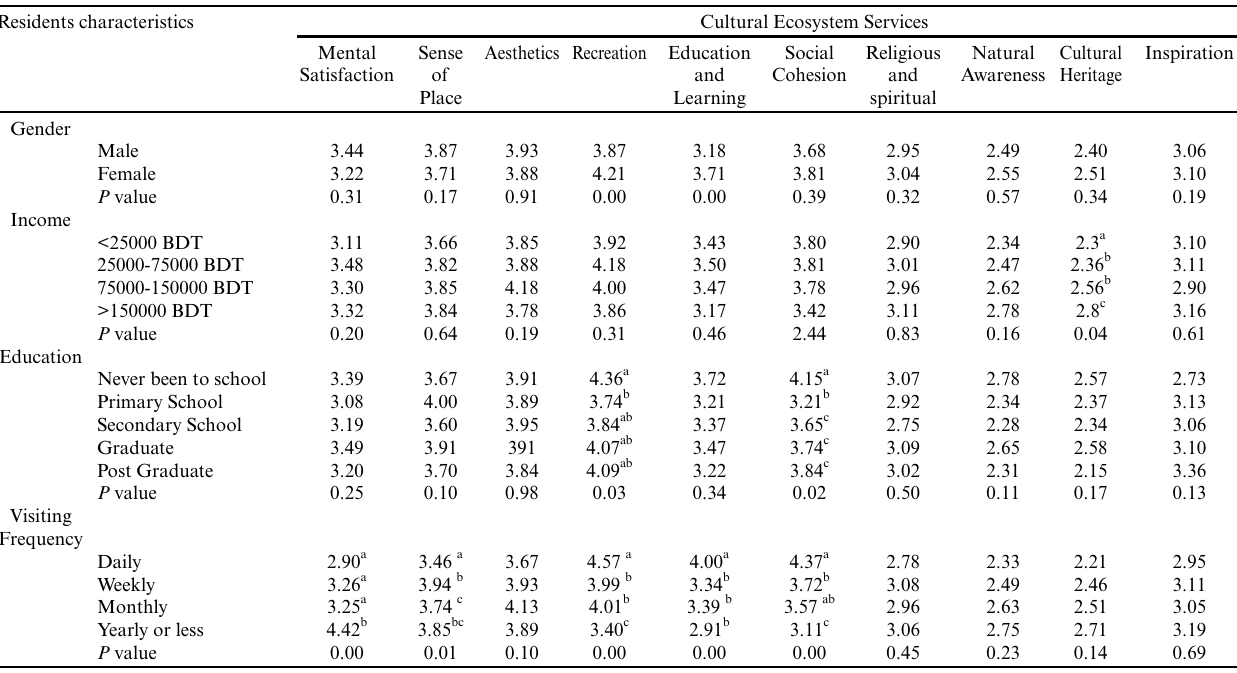
Table 2 . Importance of cultural ecosystem services depending on the respondents’ gender, income level, educational background, and visiting frequency to green spaces. Criteria of assessment: 1 = Not important, 2 = Slightly important, 3 = Moderately important, 4 = Important, 5 = Very important. a, b, and c are representing subgroups based on one way ANOVA followed by the least significant difference test (post-hoc Tukey’s test). BDT = Bangladeshi